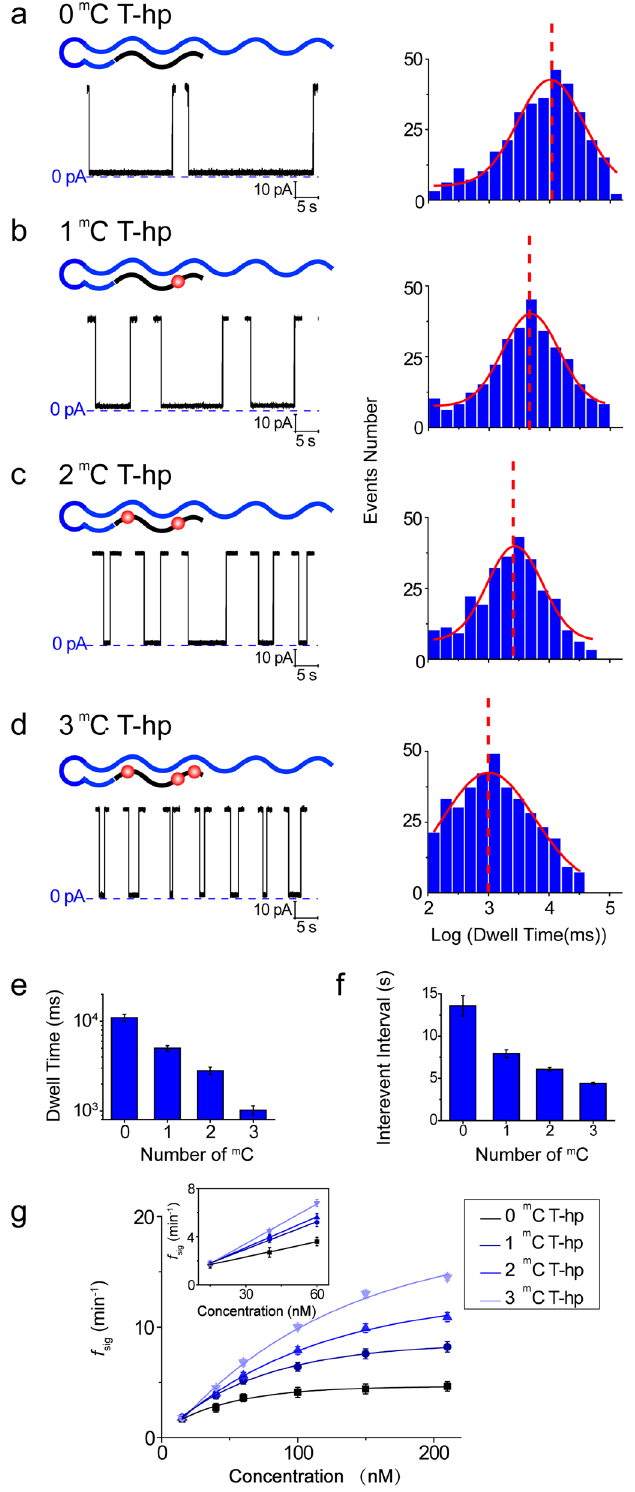
Figure 4. Methylation detection of the p16 DNA gene fragment. ( a – d ) Representative signal events and the histograms of target-probe DNA hybrids. A universal DNA probe (hp, blue colour) was used to identify and detect the methylation of different P16 gene fragments (black colour) containing zero 5 ′ -methylcytosine (0 m C T) ( a ), one 5 ′ -methylcytosine (1 m C T) ( b ), two 5 ′ -methylcytosines (2 m C T) ( c ), and three 5 ′ -methylcytosines (3 m C T) ( d ). Red represents the methylated points. ( e , f ) The peak values of log (dwell time) histogram ( e ) and mean interevent interval of hybrid DNA translocation events ( f ) for 0 m C T-hp, 1 m C T-hp, 2 m C T-hp and 3 m C T-hp. ( g ) f sig shows the concentration dependence of target DNA from 15 to 210 nM. Inset: the plot of f sig as a function of target DNA from 15 to 60 nM. Experimental conditions are the same as Fig. 1 except the applied voltage was + 60